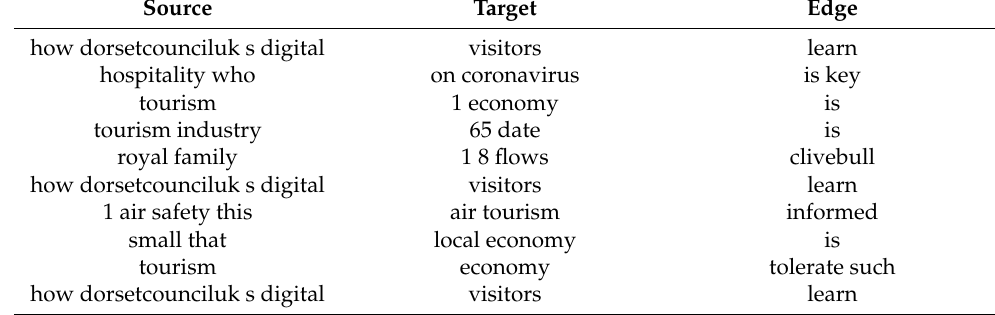
Table 10. Cluster wise Entity Relation Extraction–5.